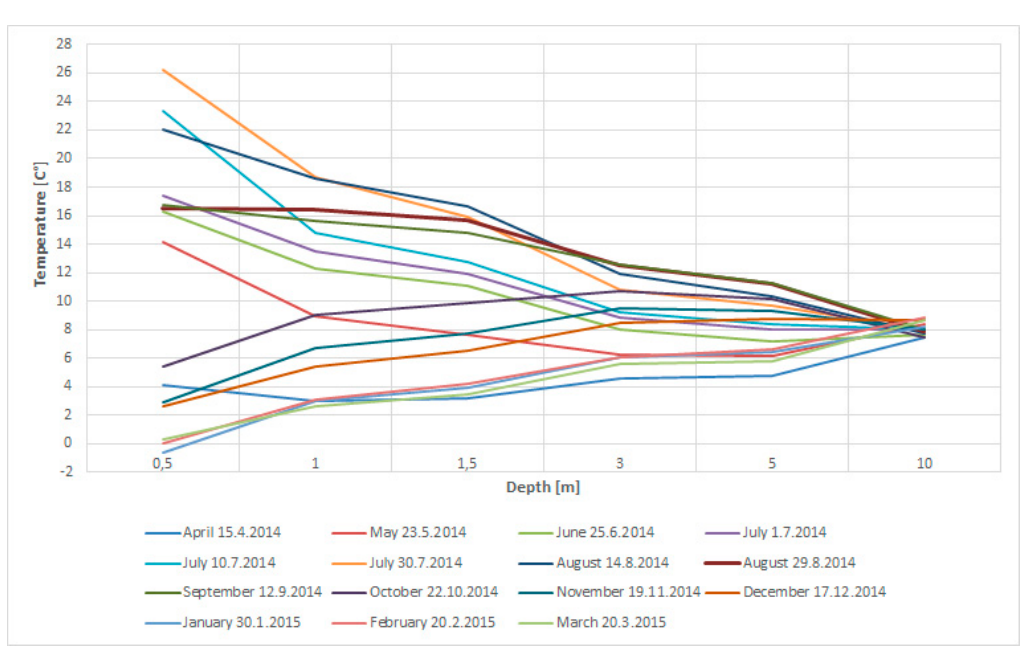
Figure 7. The temperatures in different layers from 0.5 m to 10 m are monitored at one hole. The temperatures vary between 7.4 °C and 8.8 °C at a depth of 10 m.